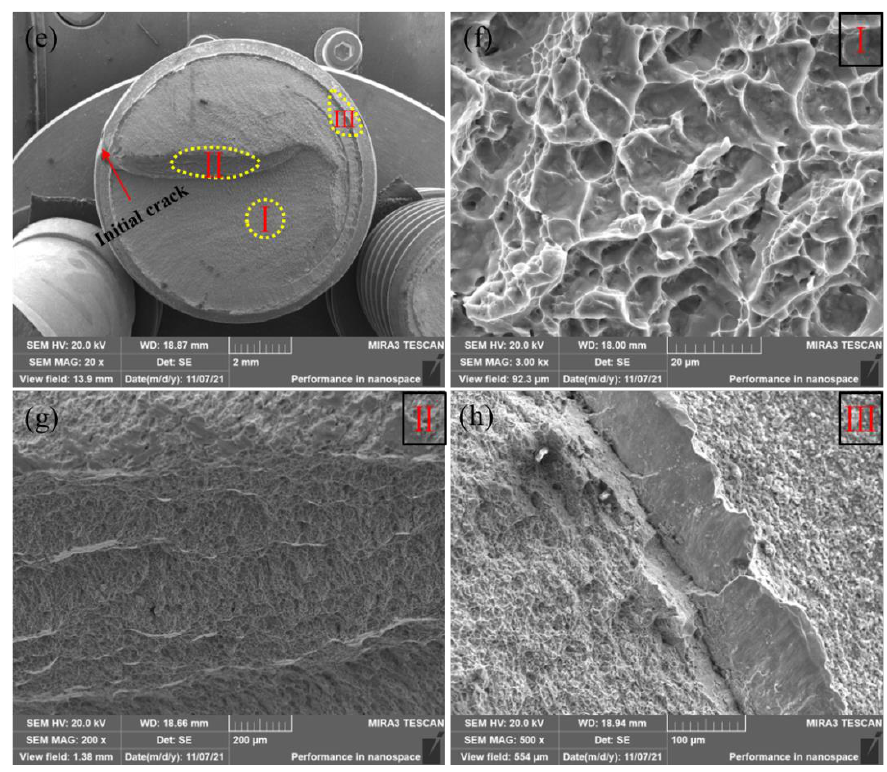
Figure 8. Fracture morphology of tensile samples: ( a – d ) for sample 1; ( e – h ) for sample 2.